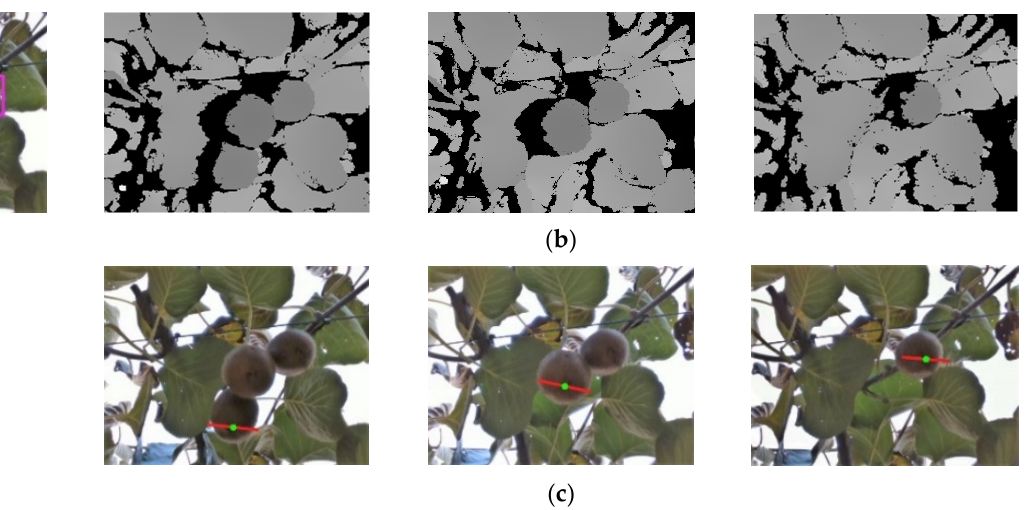
Figure 13. Robotic picking process of the manipulator in the kiwifruit orchard: ( a ) target detection; ( b ) depth images; ( c ) grasping angle; ( d ) manipulator performs grasping.